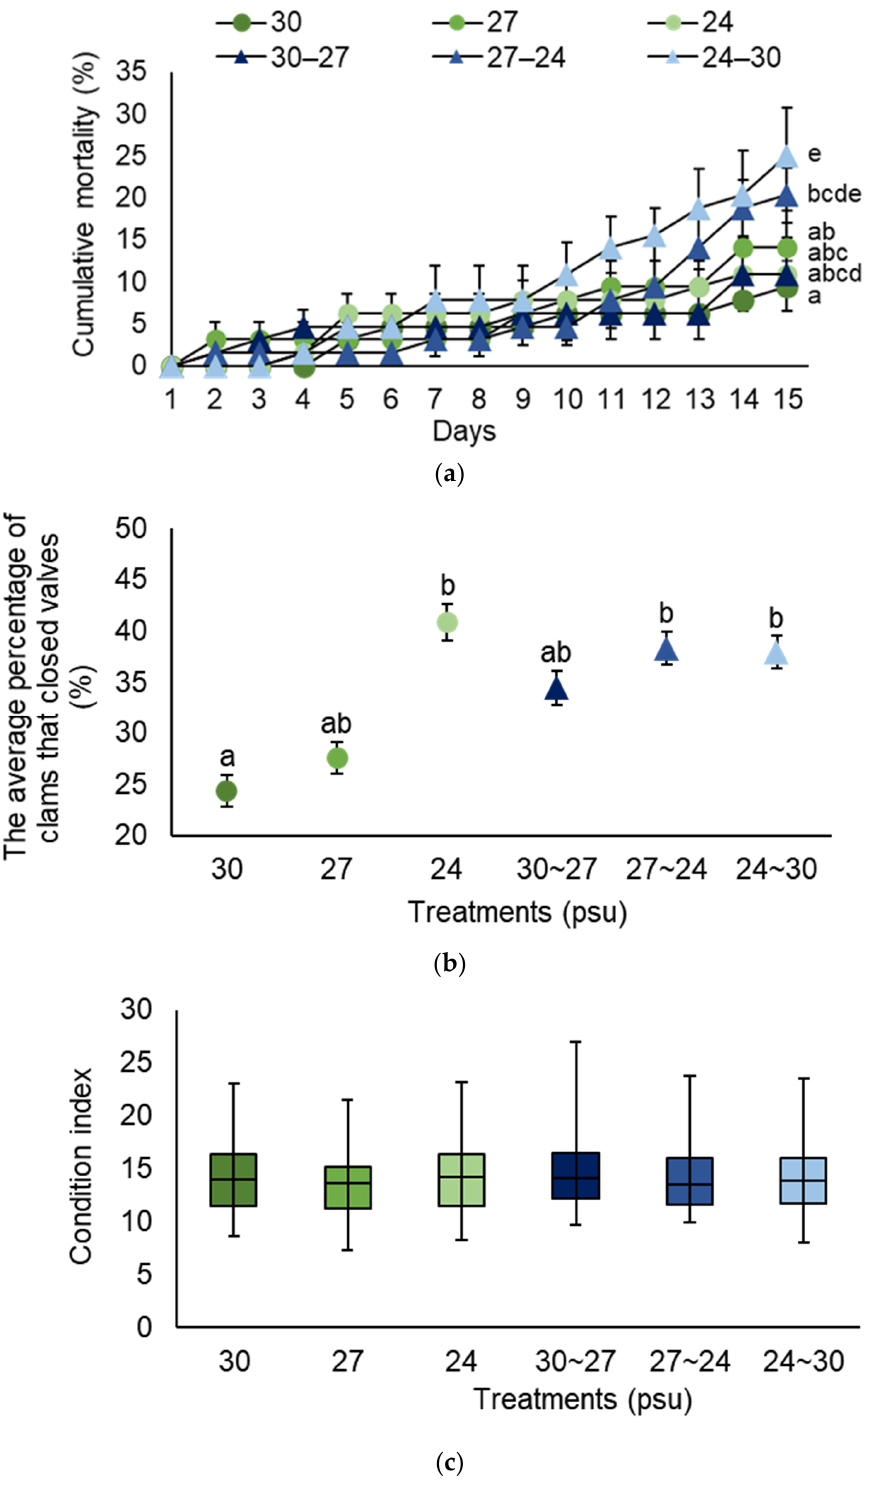
Figure 4. ( a ) Cumulative mortality rate (mean ± SE), ( b ) the average proportion of valve closure (mean ± SE), and ( c ) condition index (mean ± SE) of Venerupis philippinarum during exposure to different salinities (constant condition: 30, 27, and 24 psu, fluctuating condition: 30–27, 27–24, and 24–30 psu) for 15 days. Different letters indicate significant differences between treatments ( p < 0.05).